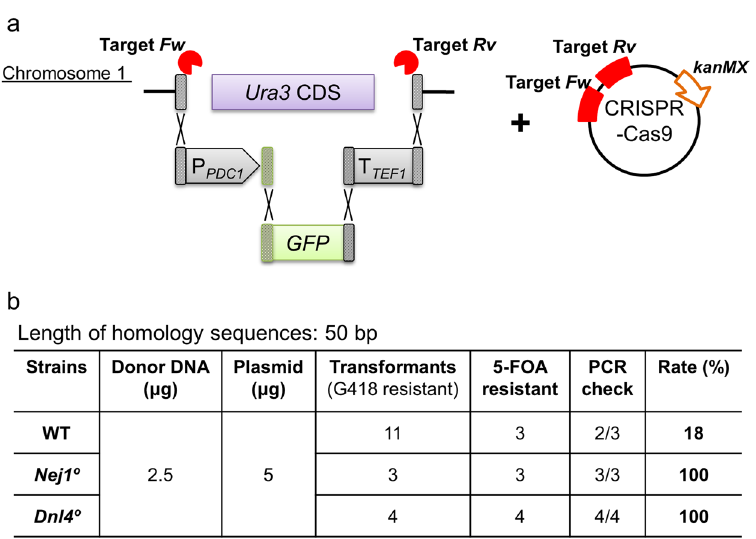
Figure 7. In vivo assembly and integration of three DNA fragments with 50 bp overlaps. ( a ) Schematic of the three transforming donor DNA fragments replacing the Ura3 locus along with the CRISPR-Cas9 plasmid targeting two sites (indicated by lightning bolts) flanking the Ura3 CDS. Dashed boxes indicate homologous regions. Bottom panel shows ( b ) Homologous recombination rate ((5-FOA resistant * PCR check)/ transformants (G418 resistant) *